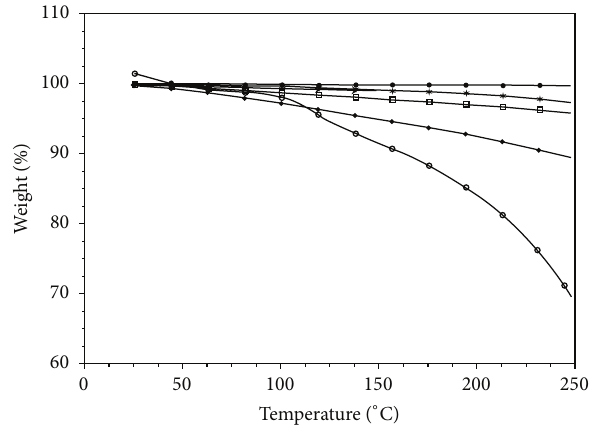
Figure 2: Behavior of weight loss for different unaged fills and reference: ( e ) Klucel G/CaCO 3 , ( X ) PB72/ 𝜇 phenolic balls, (∗) PB72/ 𝜇 glass beads, (o) PVA/CaCO 3 , ( „ ) wax/resin, and (◻) kuro- nakanuri lacquer.